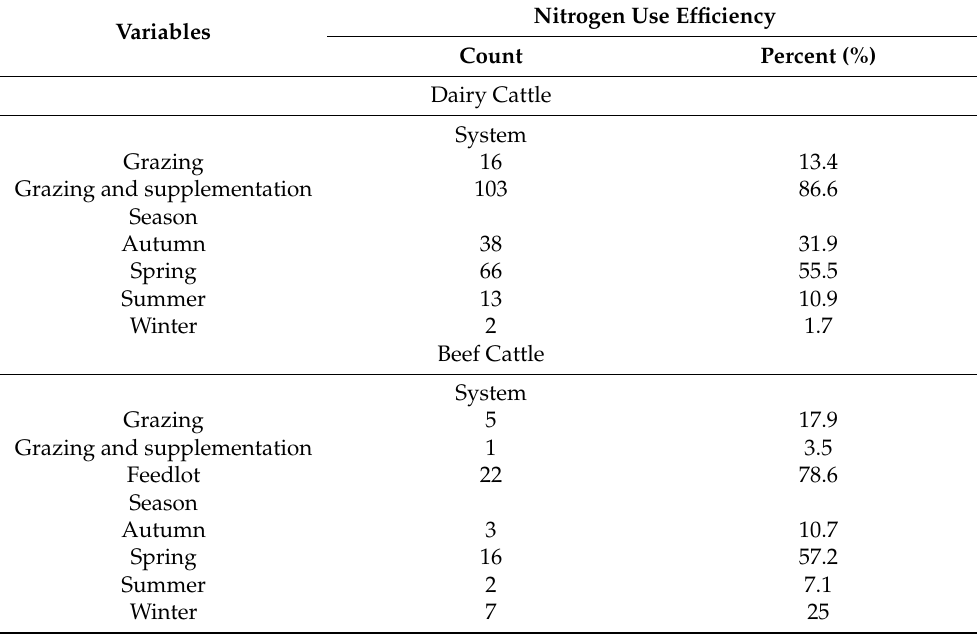
Table 2. Summary of data collated for dairy and beef cattle for nitrogen use efficiency and urinary nitrogen excretion according to animal type, production system and